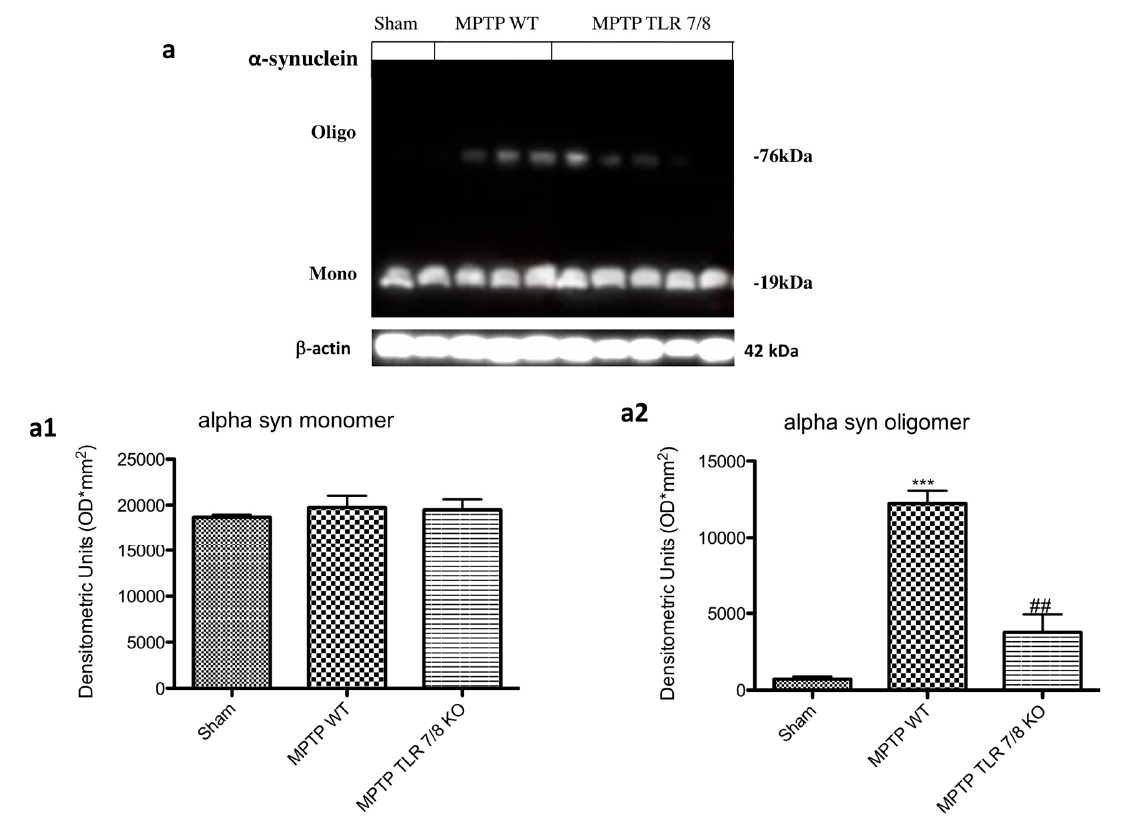
Figure 8. Effect of TLR7/8 on α -synuclein expression. Western blot analysis revealed an increase of α -synuclein in MPTP WT-injured mice ( a ; see densitometry analysis a1 , a2 ). The absence of TLR 7/8 preserved mice from α -synuclein aggregates formation ( a ; see densitometry analysis a1 , a2 ). Data are means ± SEM of 10 mice for each group. *** p < 0.001 vs. SHAM WT; ## p < 0.01 vs. MPTP WT.